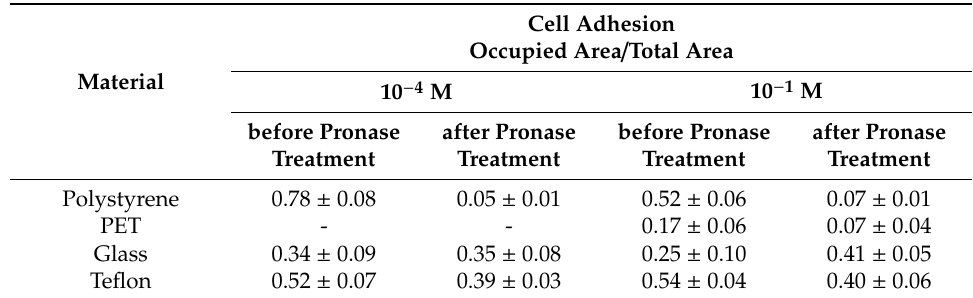
Table 4. Adhesion of Y. lipolytica IMUFRJ to polystyrene, PET, glass, and Teflon at pH 7 at 10 − 4 and 10 − 1 M ionic strength before and after treatment with pronase. Cell Adhesion Occupied Area / Total Area Material 10 − 4 M 10 − 1 M before Pronase after Pronase before Pronase after Pronase Treatment Treatment Treatment Treatment